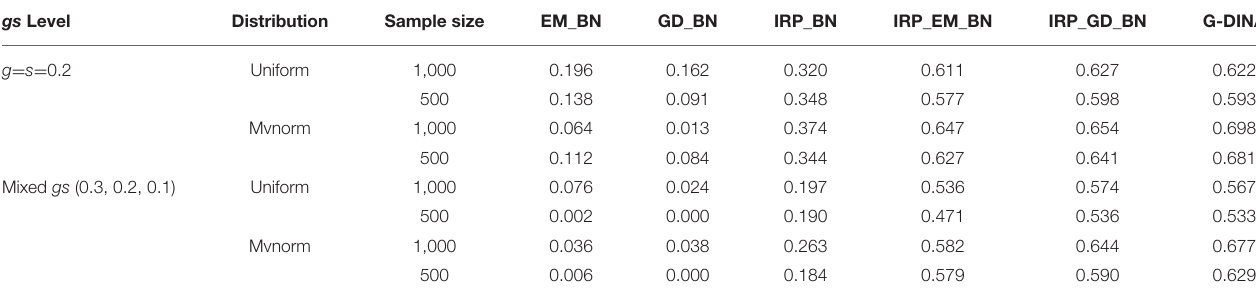
TABLE 4 | The PCR of BNs and G-DINA from the data generated by G-DINA. gs Level Distribution Sample size EM_BN GD_BN IRP_BN IRP_EM_BN IRP_GD_BN G-DINA g = s = 0.2 Uniform 1,000